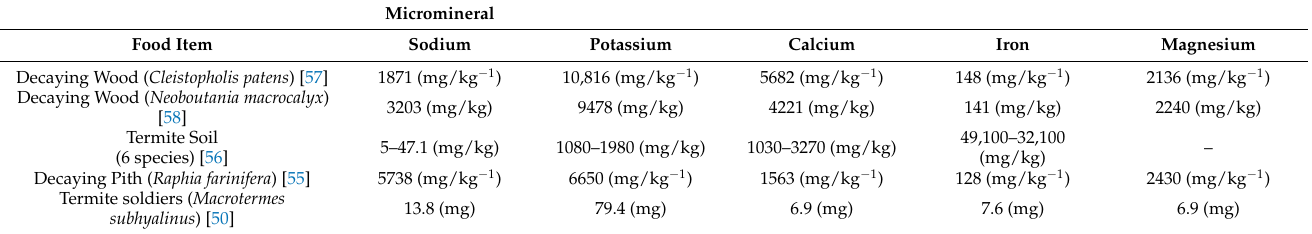
Table 3. Chimpanzee foods rich in microminerals. computed into average amounts or listed as percentages of daily intake, depending on the study’s methods. Food items were sampled from studies conducted at Bossou, Guinea and Gombe, Tanzania.